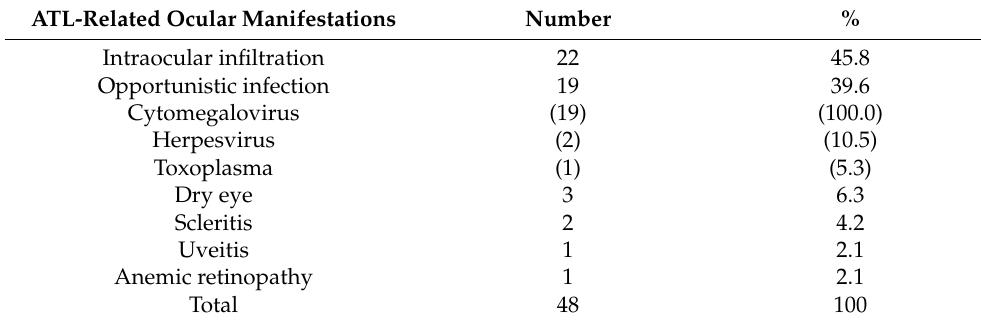
Table 3. Nationwide survey of ATL-related ocular manifestations.